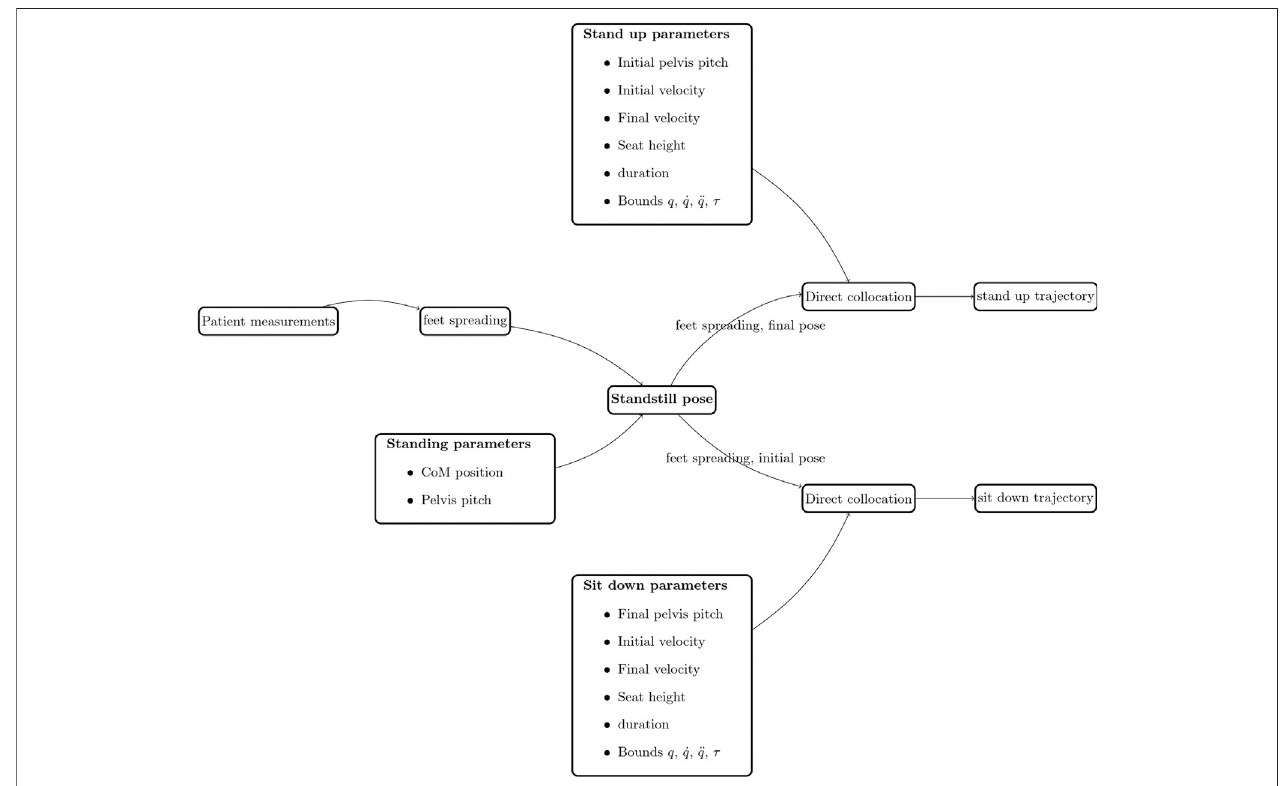
FIGURE 10 | Stand and sit trajectory generation